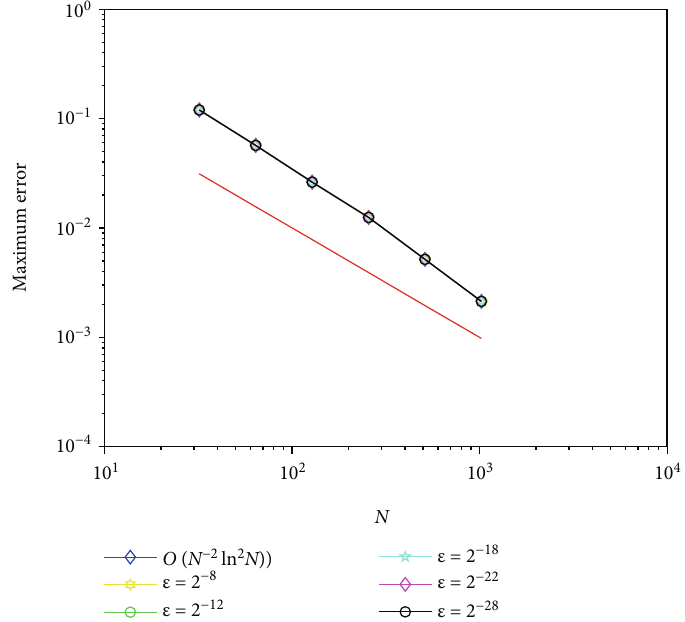
Figure 2: Plot of maximum-uniform errors in log-log scale.